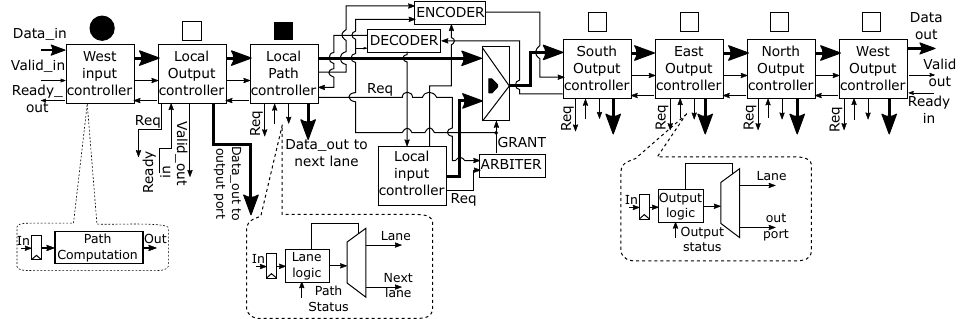
Figure 8. Implementation pipeline for lane